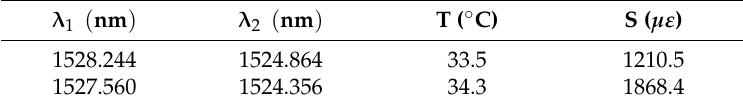
Figure 17. ( a ) Transmission spectrum shift of the central core and the outer core with different temperature; ( b ) Transmission spectrum response as a function of temperature [139]. Table 2. Measured value λ 1 , λ 2 , determined temperature, and strain using MCF [139].